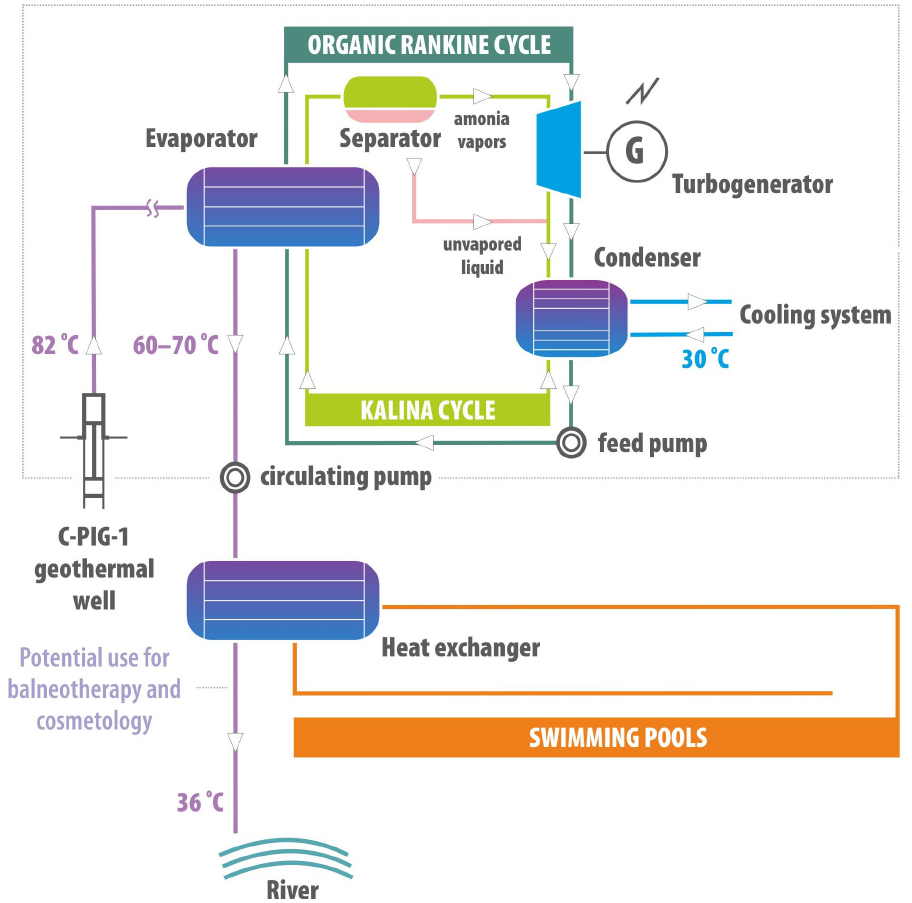
Figure 2. Schematic diagram of a cascade system for the C-PIG-1 geothermal well.